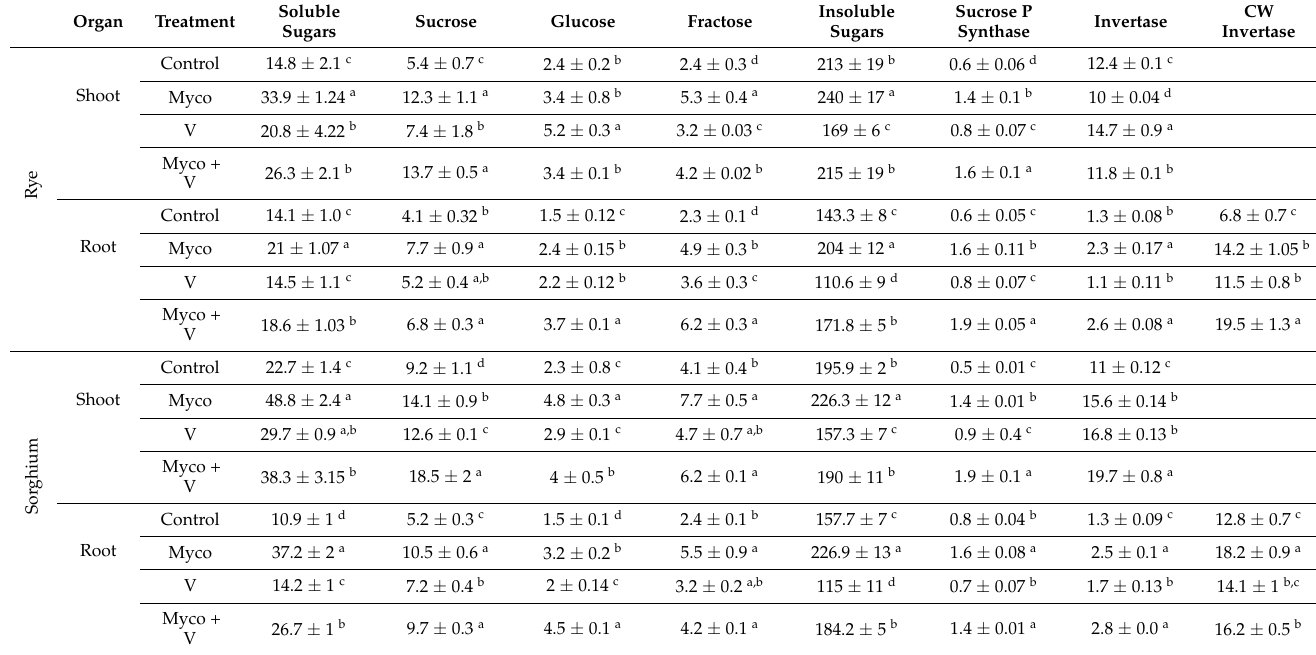
a,b,c,d Different letters indicate statistically significant difference between means of the same plant species at significance level of at least ( p ≤